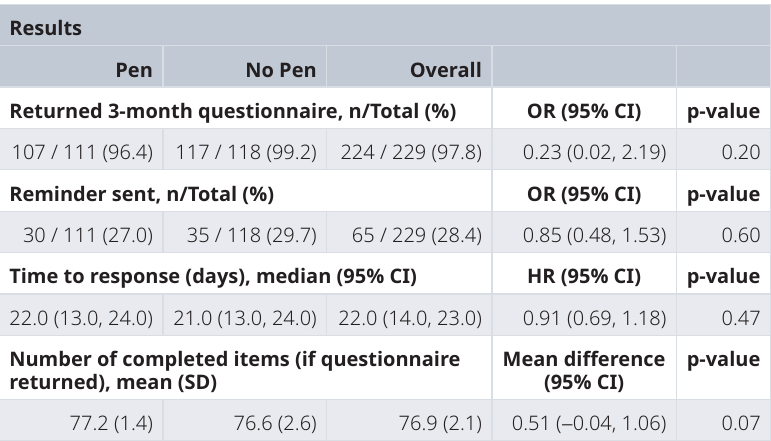
Table 2. Summary of SWAT trial results (ITT